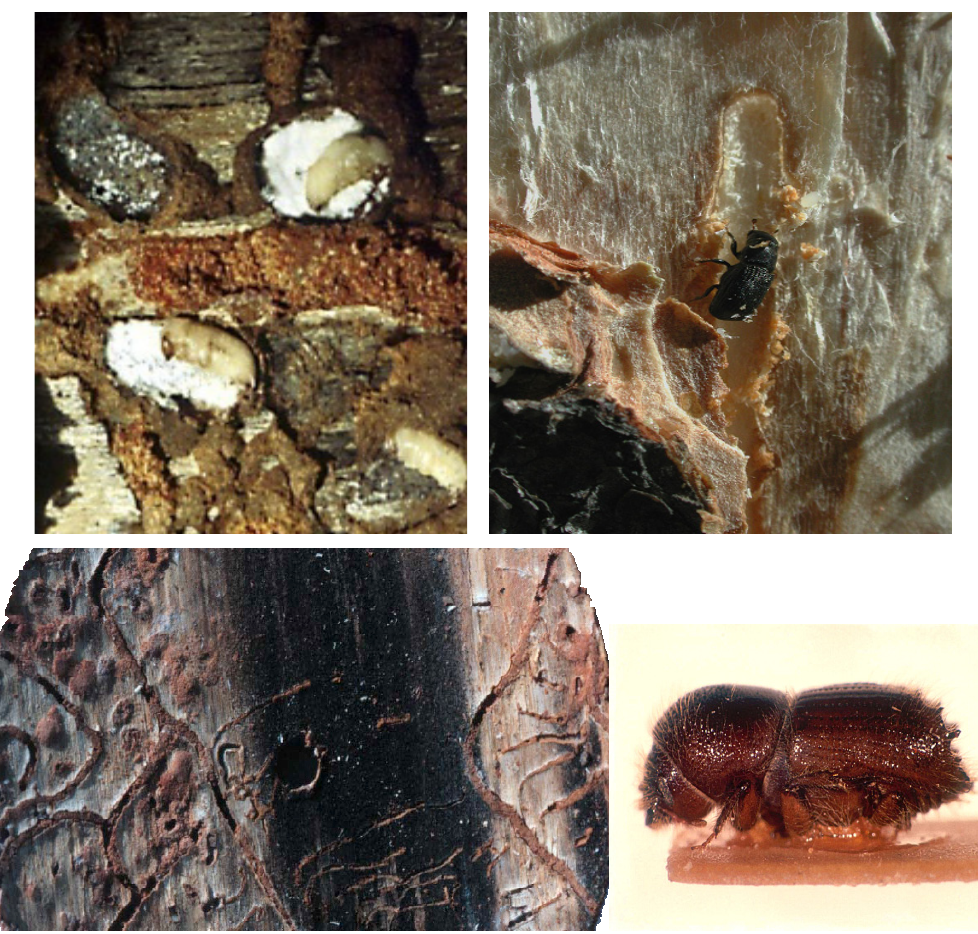
Figure 3. Examples of bark beetles and their galleries. Left to right, top to bottom: Pupal chambers containing Dendroctonus.ponderosae pupae and spore layers of fungi, courtesy of the author; D. ponderosae adult, courtesy of the author; Bark section showing extensive beetle development in light portions colonized by mutualistic fungal symbionts and lack of development in highly stained portion of bark colonized by the antagonistic fungus, O. minus (arrow) courtesy of Fred Stephen; I. pini courtesy of Jesse